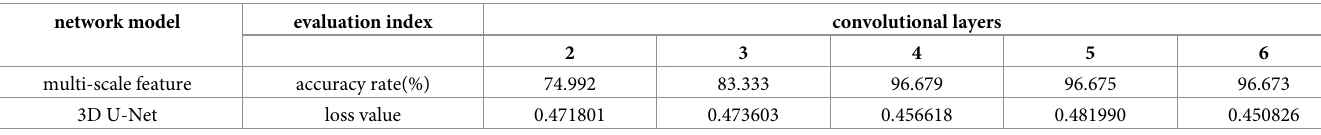
Table 4. The performance comparison of different convolutional